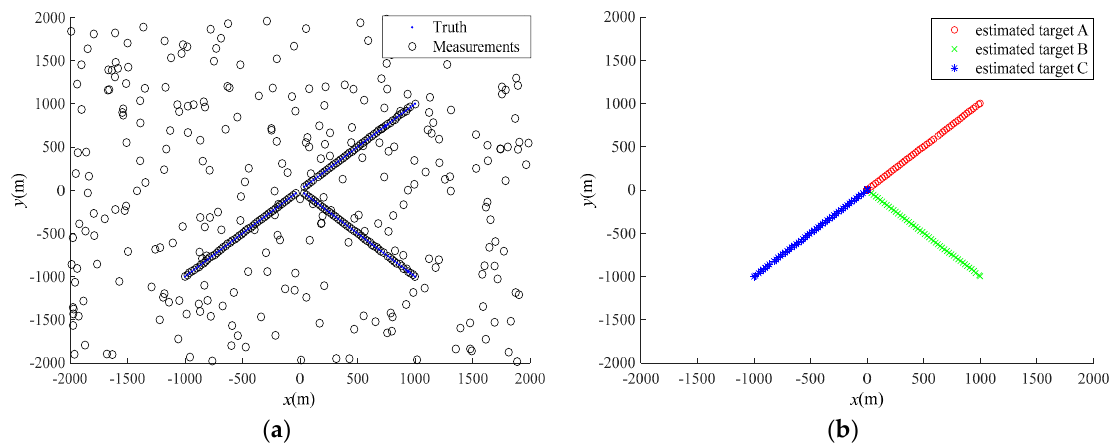
Figure 6. Multi-target tracking results for a single run: ( a ) the true target trajectories and received measurements; ( b ) estimated target trajectories.